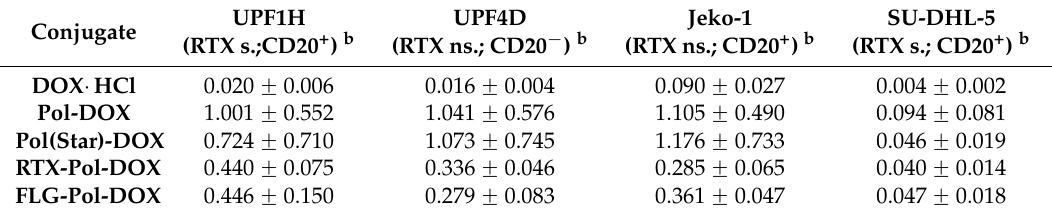
Table 3. Cytostatic activity a of polymer